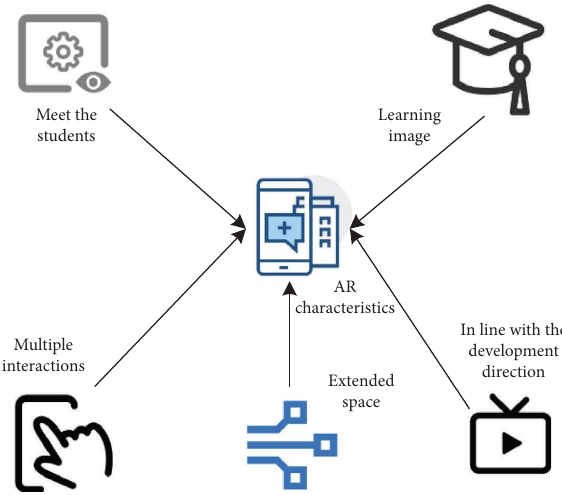
Figure 2: Advantages of AR technology.